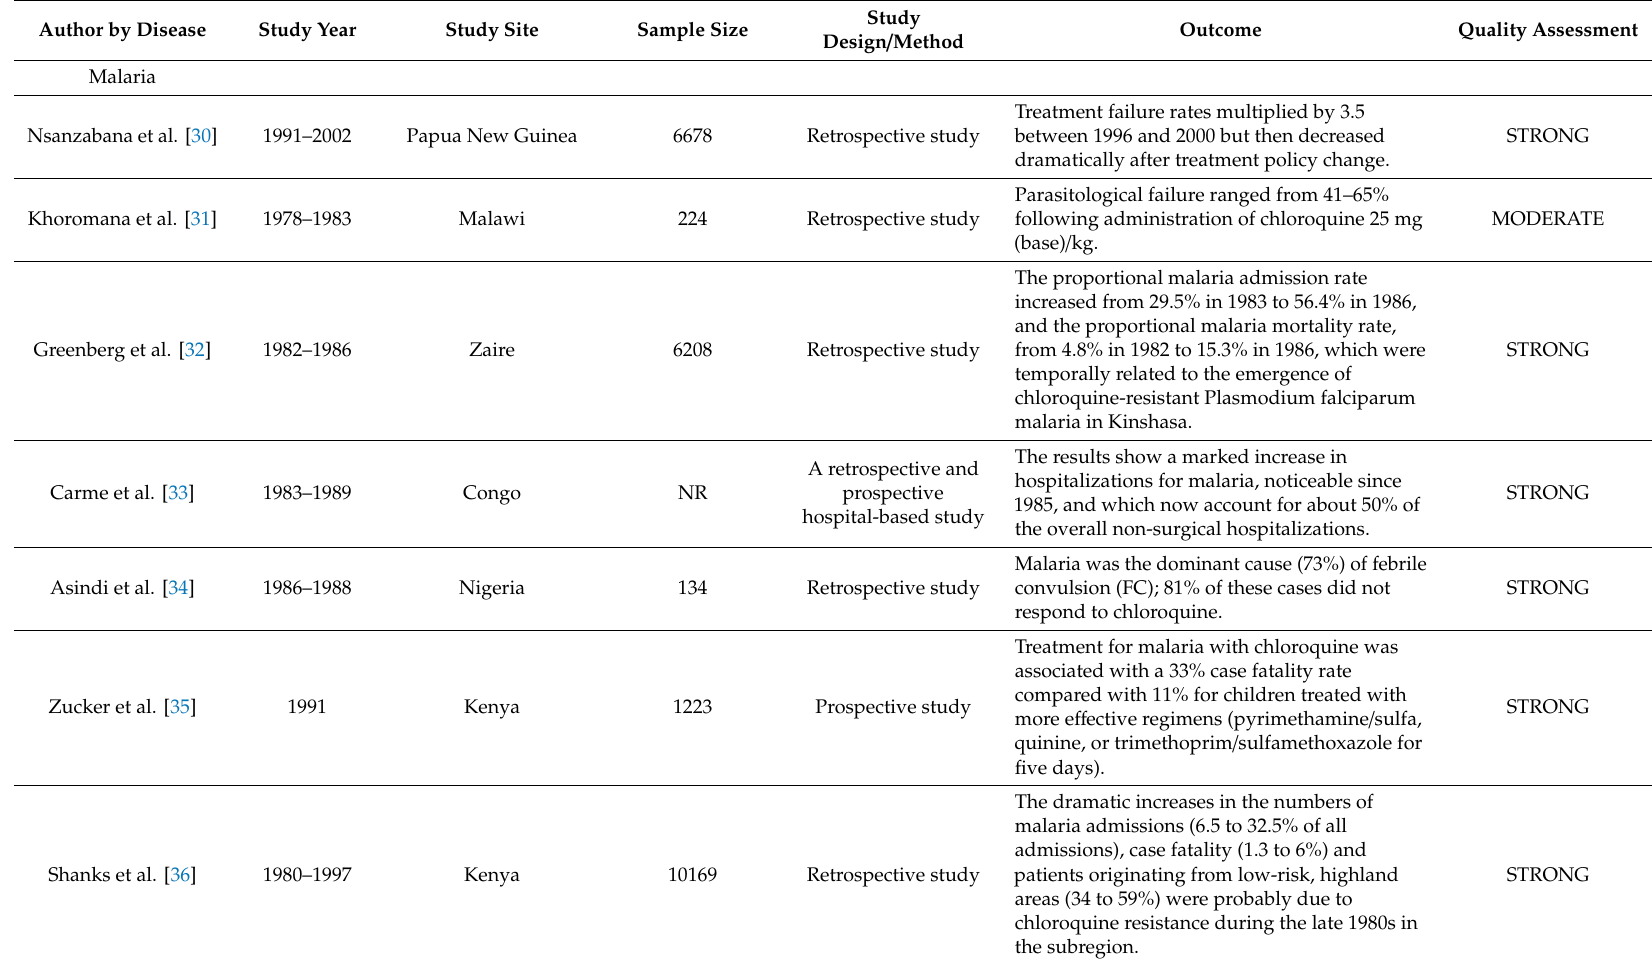
Table 2. Characteristics of included studies on clinical outcomes due to